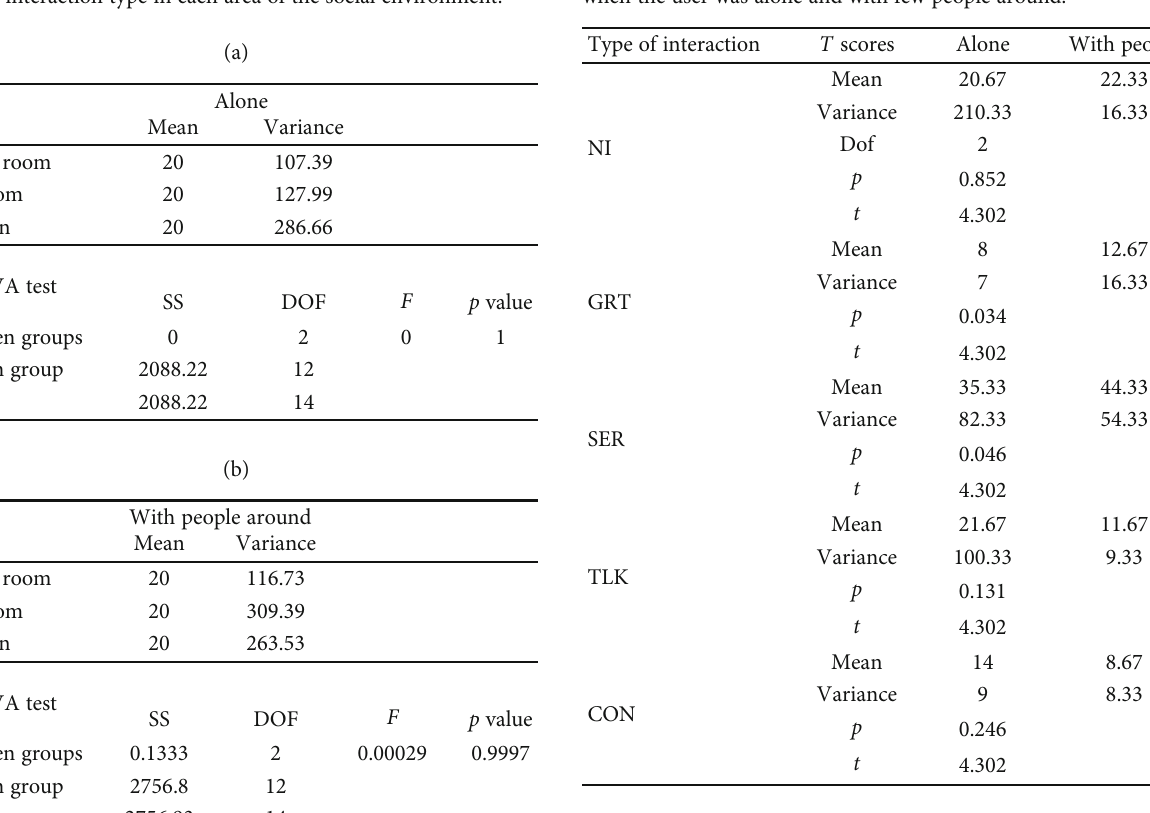
Table 3: ANOVA test for the comparison of percentage frequencies of each interaction type in each area of the social environment.